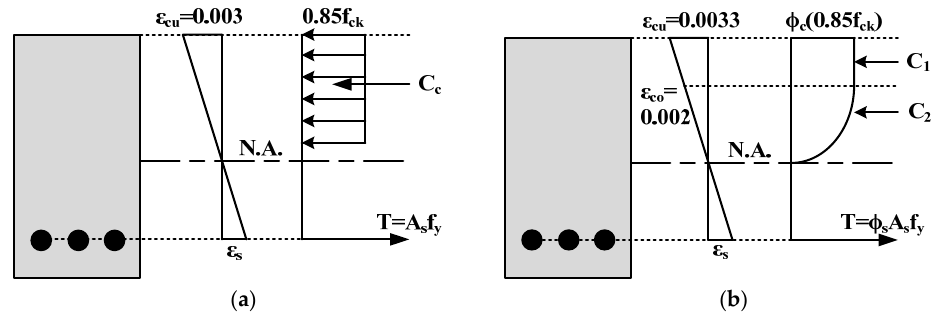
Figure 6. Stress and strain relationship between concrete and steel: ( a ) rectangular stress distribution of strength design method; ( b ) parabolic stress distribution of limit state design method.